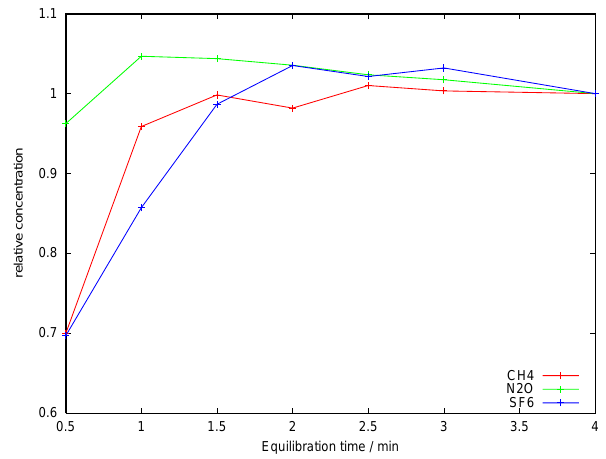
Figure 5. Relative gas concentration vs. equilibration time for SF 6 , N 2 O and CH 4